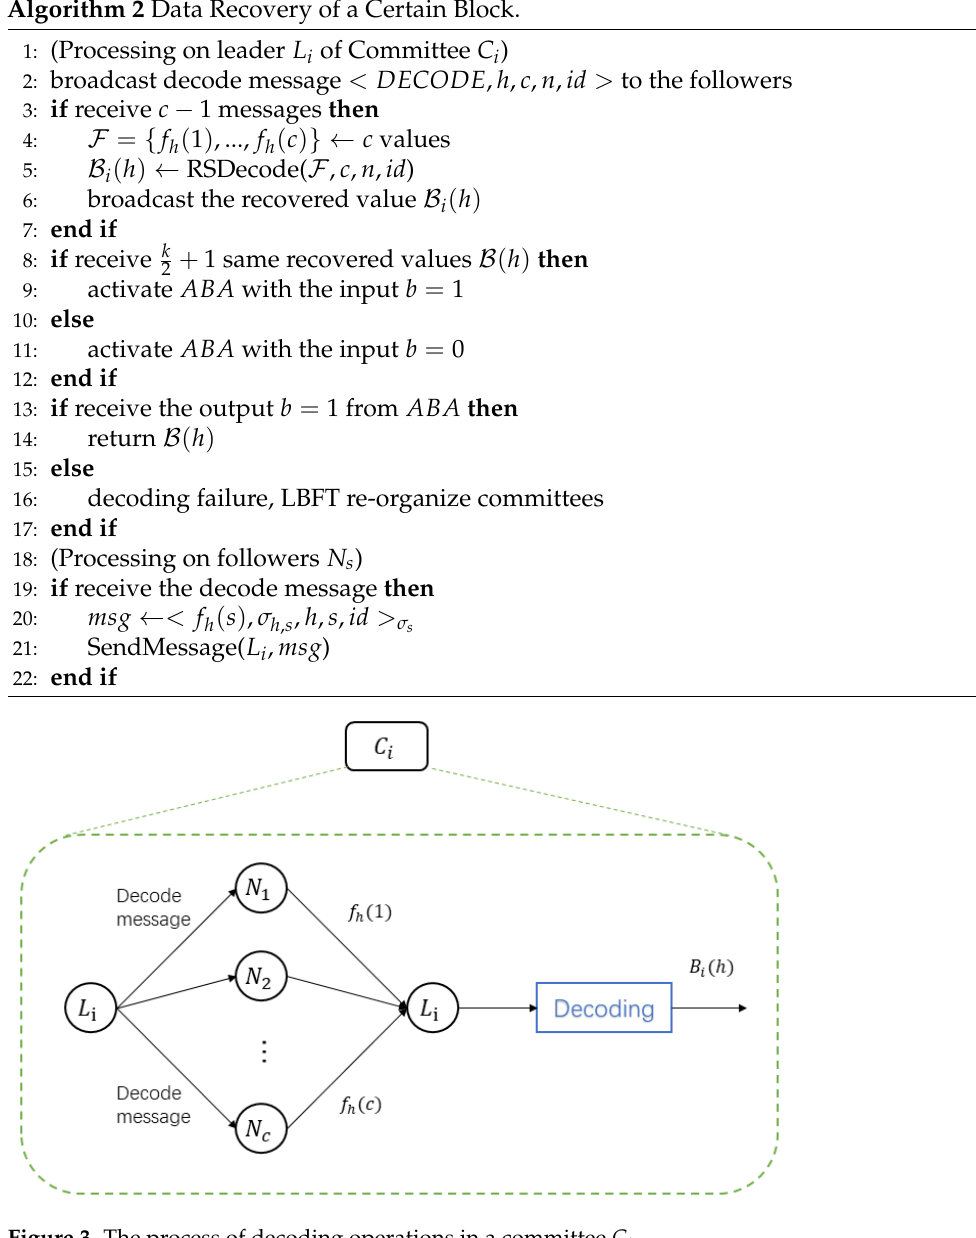
Figure 3. The process of decoding operations in a committee C i